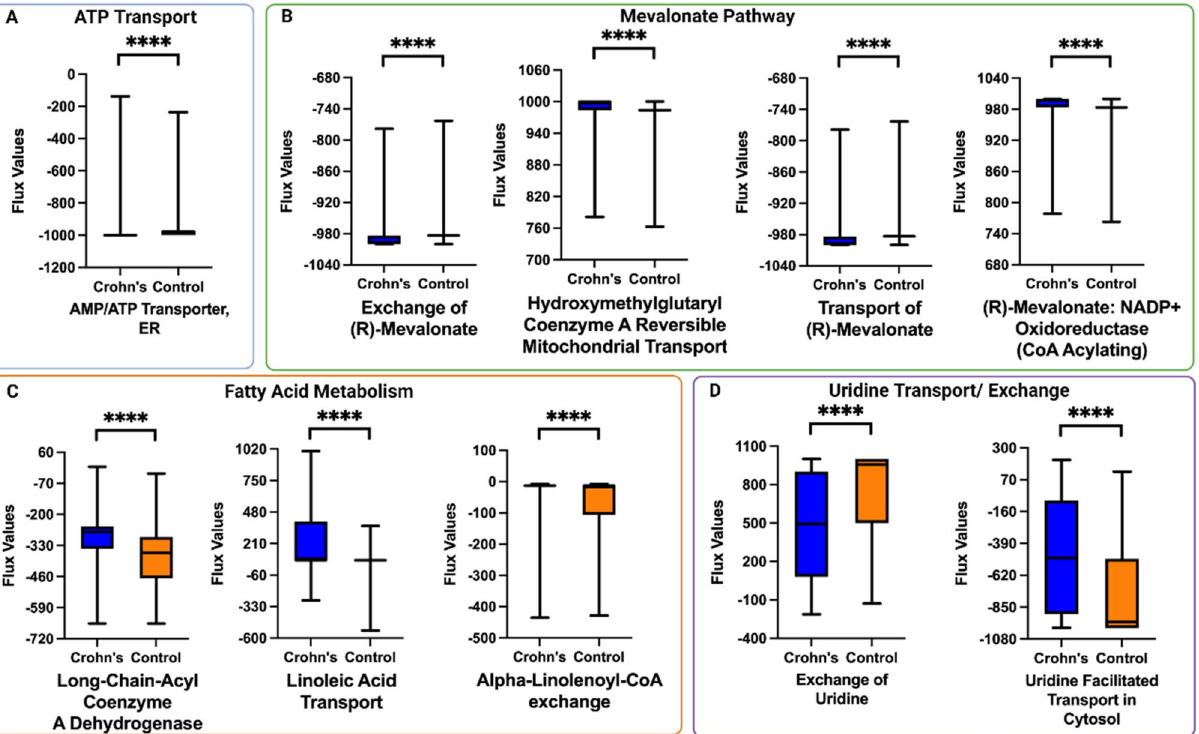
Figure 2. Metabolic pathways with an altered flow in patients with Crohn’s disease (CD) versus control patients. The Flux Balance Analysis/Random Forest framework outlined in Fig. 1 were applied to the RISK dataset. After obtaining the list of top metabolic reactions that were altered between CD and control groups, these reactions were grouped into "families" ( A–D ) based on the biological processes they were involved in: ( A ) ATP transport processes were found to have significant rates of flux. ( B ) Mevalonate pathway. Several enzymes within the mevalonate pathway were altered in patients with CD, including the exchange of R- mevalonate, hydroxymethylglutaryl coenzyme A reversible mitochondrial transport, transport of R- mevalonate, and R- mevalonate NADP + oxidoreductase (CoA acylating), ( C ) Fatty acid oxidation. Long-chain-acyl Coenzyme A dehydrogenase, linoleic acid transport, and alpha-linolenoyl-CoA exchange ( D ) Uridine transport and exchange. For all graphs, the x-axis describes the reaction that is altered between controls (orange) and diseased states (blue). The y-axis shows the flux values generated by RIPTiDe by analyzing the flow of metabolites through an ileal-specific metabolic network reconstruction. The scale of flux values (y-axis) varies with the reactions as the efficiency of different metabolic pathways in generating biomass varies in a given biological system. A Mann–Whitney U test was done to compare reactions that varied between patients with Crohn’s disease and controls. The stars (*) are used to flag levels of significance. * p < 0.05, ** p < 0.01, *** p < 0.001. AMP: adenosine monophosphate; ATP: adenosine triphosphate; ER: endoplasmic reticulum; NADP + : nicotinamide adenine dinucleotide phosphate CoA: Coenzyme